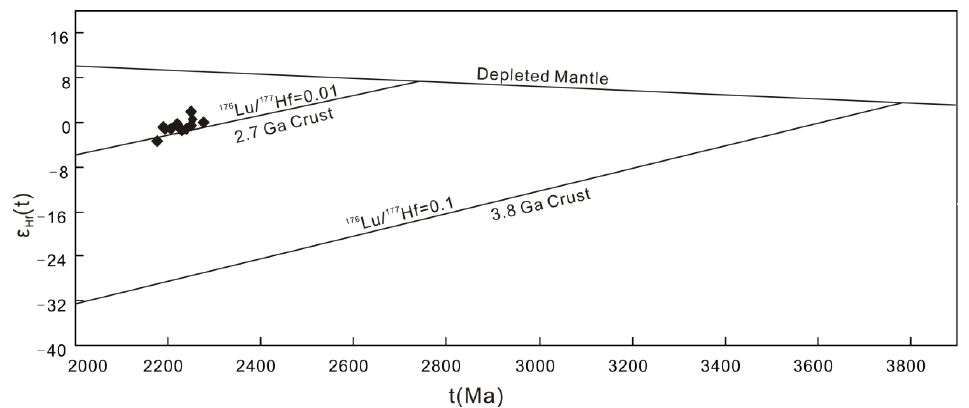
Figure 11. Diagram of zircon ε Hf (t) values vs. U-Pb ages for granodiorite porphyries at Tongkuangyu Cu deposit (2.7 Ga and 3.8 Ga crust lines were constructed through 2.7 Ga diorite [25] and Songjiashan Formation (detrital zircon) [28] assuming a 176 Lu/ 177 Hf ratio of 0.01).